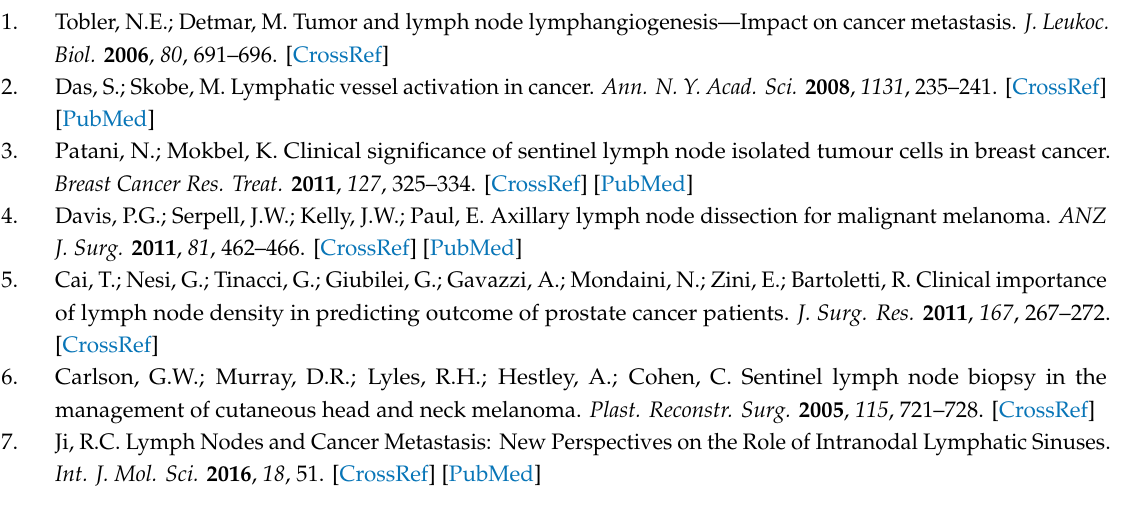
Figure S1: Treatment of the conditioned medium of LC cancer cells upregulated the expression of inflammatory genes, chemokines and cytokines in LECs; Figure S2: Expression of CXCR2 on the surface of MDA-MB-231 and LC breast cancer cells detected by flow cytometry; Figure S3: Expression of CXCR2 on the surface of CD11b + / Gr-1 + MDSCs detected by flow cytometry; Figure S4: CXCR2 inhibitor prevents MDSC recruitment to tumors, tumor-draining lymph nodes (TDLN) and distant lymph nodes. (A) SB225002 was injected 48 h before the inoculation of cancer cells into the mammary fat pads of nude mice. Tumors, spleens, and lymph nodes were harvested for analysis two weeks later. (B) The tumors weight of the control and SB225002-treated mice were not significantly di ff erent. (C) The amount of CD11b + / Gr-1 + MDSCs in tumor, spleens and lymph nodes was investigated by flow